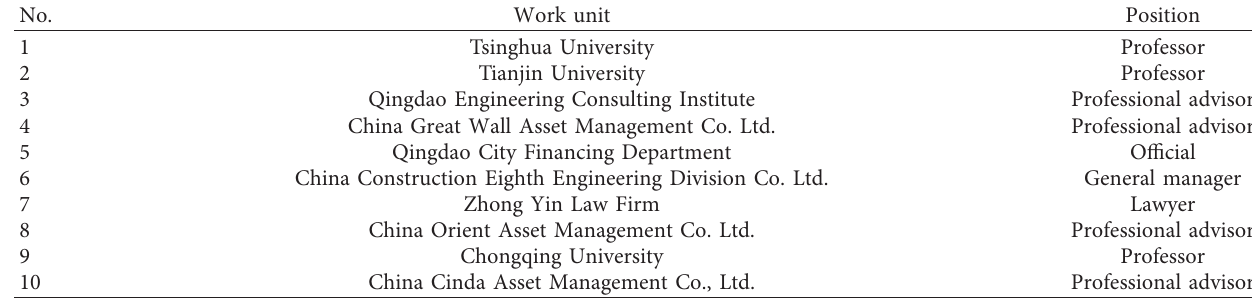
Table 2: Information of the experts.